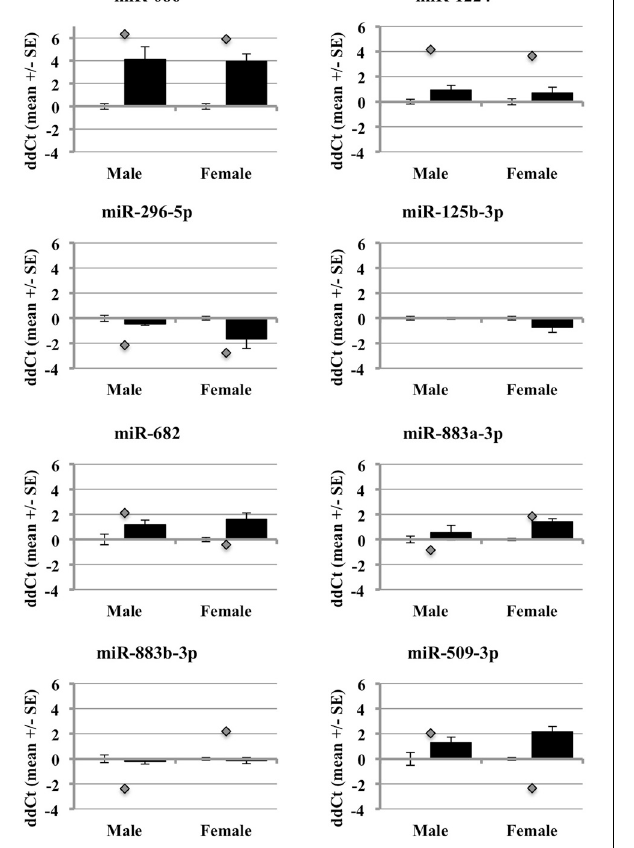
FIGURE 5 | Comparison of miRNA array expression to individual qRT-PCR assays in male and female mouse cortex. The graphs show the (cid:2)(cid:2) Ct of male and female miRNAs control (white bar) or ischemic (black bar) mouse cortex. The graphs also include the (cid:2)(cid:2) Ct for each miRNA as detected in the miRNA arrays (gray